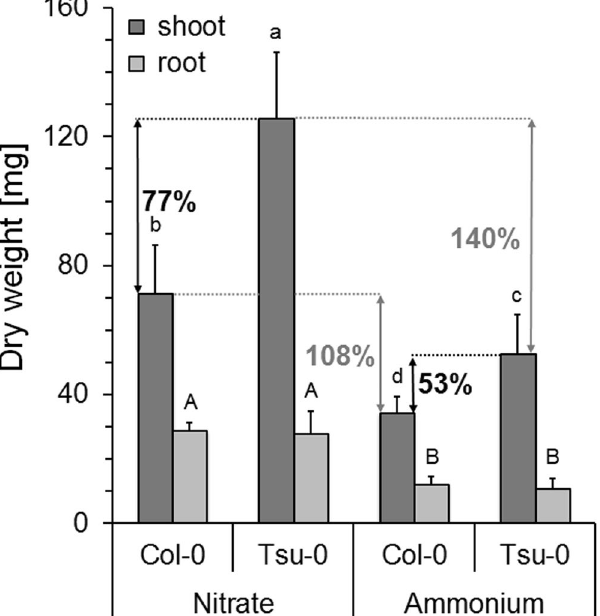
Figure 4. Superior growth of Tsu-0 grown under exclusive nitrate supply. Shoot and root dry weight [mg] of Col-0 and Tsu-0 plants grown in ammonium nitrate for 14 days and then transferred to single nitrogen sources for 21 days. Data represent a total of n = 21 plants per accession and N-regime. Data is given as means ± SD. The symbols A and B indicate significant differences (ANOVA) in root dry weight (p < 0.01), a, b, c, d indicate significant differences in shoot dry weight (p < 0.01). Black numbers [%] indicate growth increase of Tsu-0 compared to Col-0 in the respective N-form. Gray numbers indicate the growth increase of the respective accession between growth in nitrate, compared to growth in